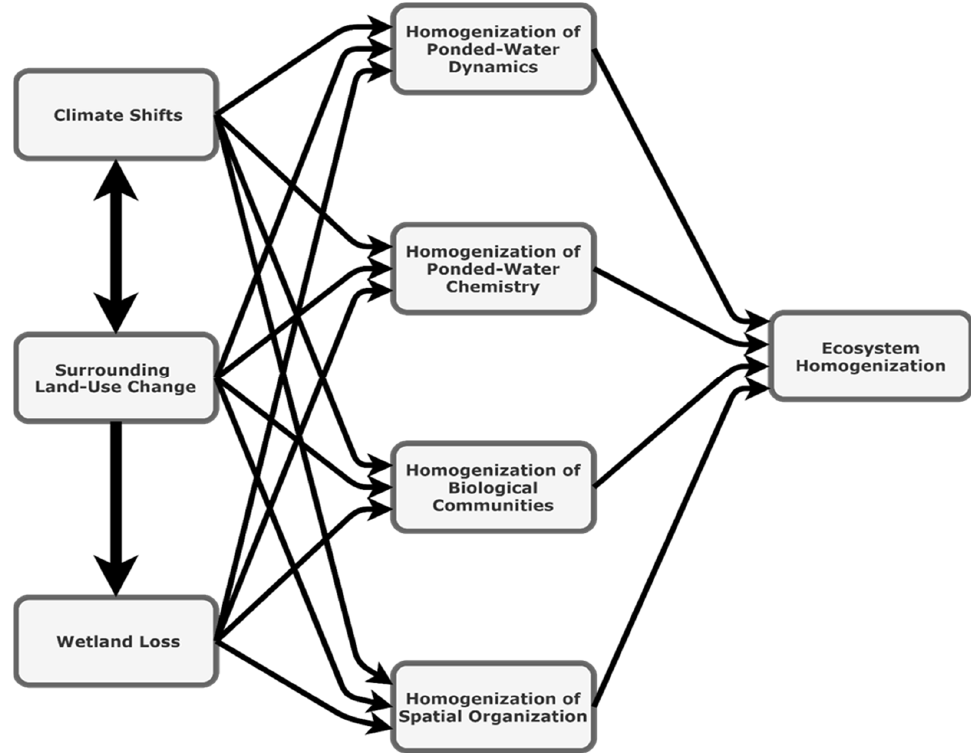
Figure 1. Conceptual model indicating hypothesized connections between climate shifts, land-use change, wetland losses, and components of wetland ecosystem variability, leading ultimately to ecosystem-level homogenization.